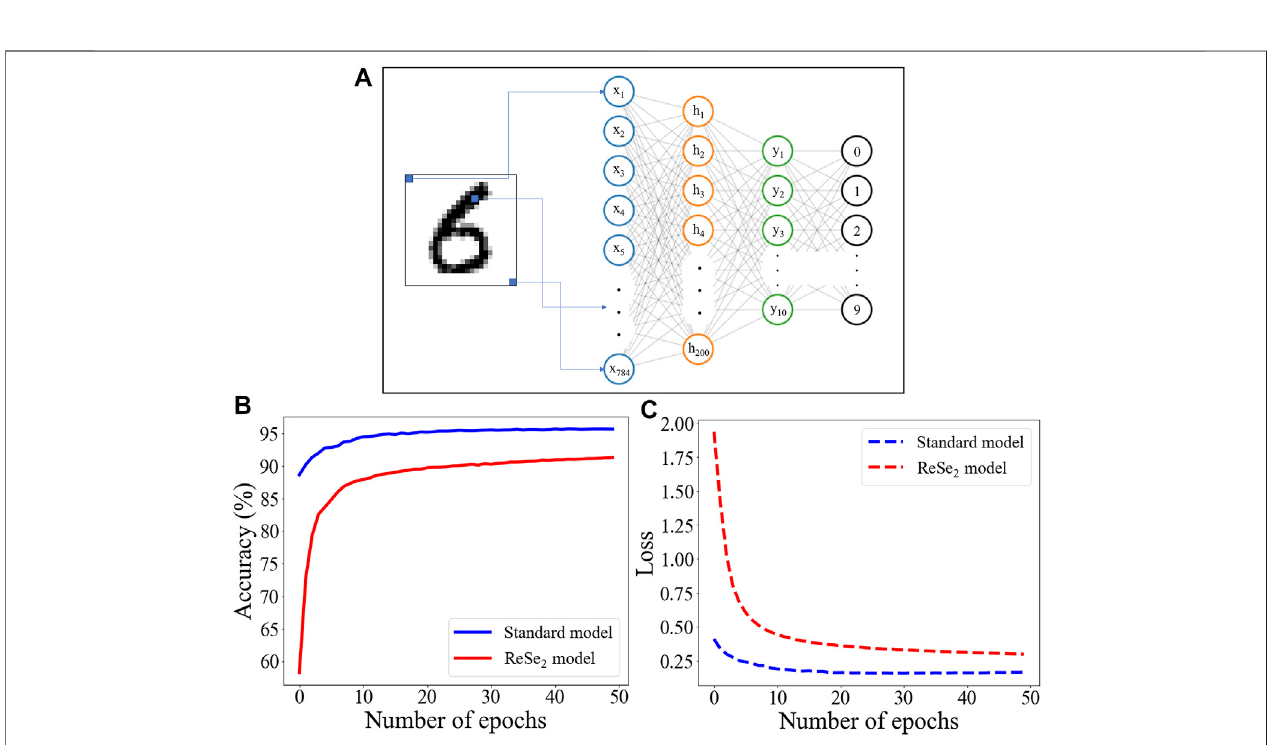
FIGURE 7 | Application of ReSe 2 RRAM for handwriting number recognition with MNIST dataset. (A) Schematic illustration of the ANN structure designed for the simulation. Comparison of (B) accuracy and (C) loss between models with standard and ReSe 2 RRAM-based SGD optimizers.